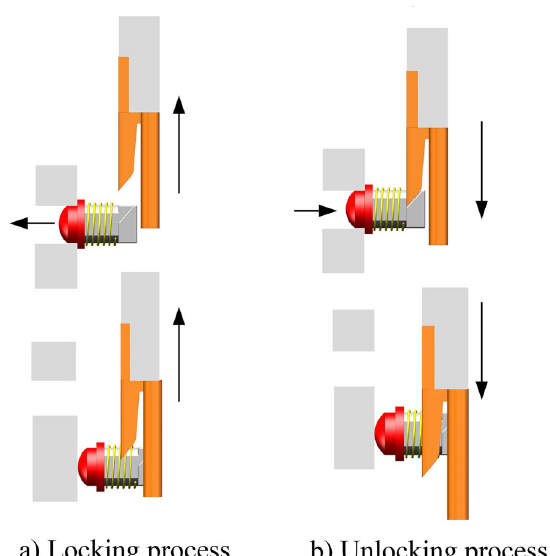
Figure 3 Pin lock and unlock process